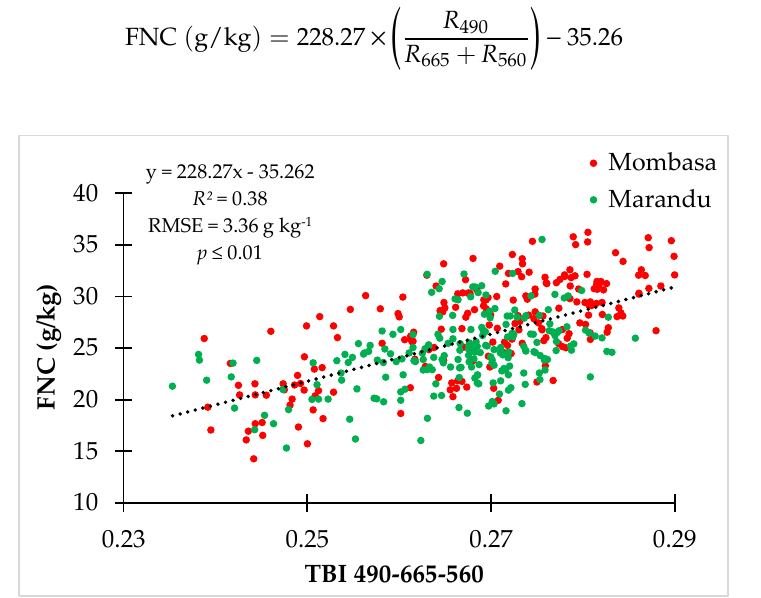
Figure 7. FNC (g kg −1 ) graphic representation, as a function of the TBI vegetation index based on Sentinel-2 bands in the Marandu and Mombasa experimental study area.